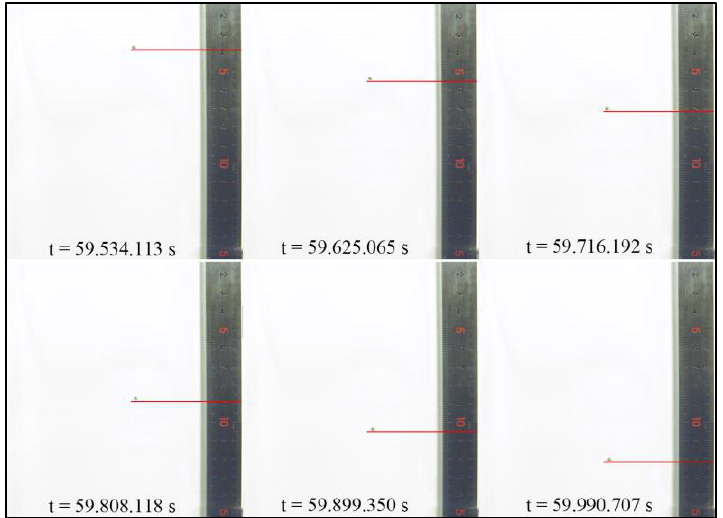
Figure 6. Examples of a single particle during the settling process.